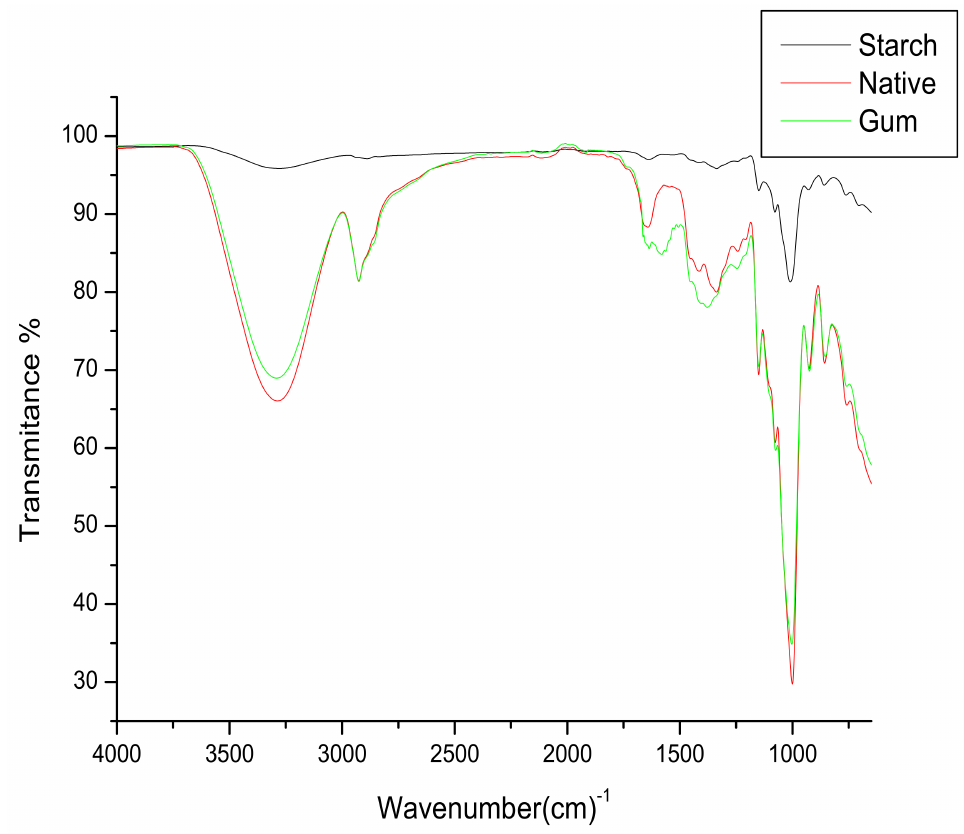
Figure 6. FTIR of proso millet starch, native film, and starch–k-carrageenan film. During the FTIR analysis, different native film peaks were observed. The peak at 479.79 cm − 1 represents polysulfides (S–S stretch) group; 522.54 cm − 1 and 559.28 cm − 1 represent aliphatic iodo compounds (C–I stretch); 758.51 cm − 1 represents aliphatic chloro compounds (C–Cl); 857.38 cm − 1 represents peroxides (C–O–O– stretch); 926.25 cm − 1 represents aliphatic phosphates (P–O–C stretch); 1076.30 cm − 1 and 1149.93 cm − 1 represent aliphatic fluoro compounds (C–F); 1242.90 cm − 1 represents epoxy and oxirane rings; 1337.37 cm − 1 represents primary or secondary (OH in-plane bend group); 1414.34 cm − 1 represents carboxylate (carboxylic acid salt); 1641.39 cm − 1 represents primary amine (NH bend); 1985.25 cm − 1 represents aromatic combination bands; 2113.25 cm − 1 represents different ions such as thiocyanate, cyanide, and related derivatives; 2925.98 cm − 1 represents methoxy, C–H stretch (CH 3 –O–); 3287.98 cm − 1 represents ammonium ions. During the FTIR analysis of the CG film, different peaks were observed. The peak at 479.93 cm − 1 represents the polysulfides (S–S stretch) group; 521.67 cm − 1 and 558.75 cm − 1 represent aliphaticiodo compounds (C–I stretch); 758 cm − 1 represents aliphatic chloro compounds (C–Cl); 854.55 cm − 1 represents peroxides (C–O–O–) stretch; 924.62 cm − 1 represents aliphatic phosphates (P–O–C stretch); 1074.84 cm − 1 and 1149.68 cm − 1 represent aliphatic fluoro compounds (C–F); 1246.13 cm − 1 represents epoxy and oxirane rings; 1378.25 cm − 1 represents primary or secondary (OH in-plane bend); 1505.38 cm − 1 represents (C=C–C) aromatic ring stretch; 1580.24 cm − 1 represents secondary amine (>N–H bend); 1636.53 cm − 1 represents primary amine (NH bend); 1662.91 cm − 1 and 1914.05 cm − 1 show aromatic combination bands; 2113.80 cm − 1 represents cyanide ion, thiocyanate ion, and related ions; 2925.71 cm − 1 represents methoxy, C–H stretch (CH 3 –O–); 3290.07 cm − 1 represents ammonium ions. Guan et al. [48] observed that the inclusion of k-carrageenan results in shifting absorption bands toward 3280 cm − 1 and 2922 cm − 1 , which ultimately showed blending. Ramos et al. [49] demonstrated specific bands at 998 to 1148 cm − 1 , corresponding to C–C and C–O bond vibrations. Gutierrez et al. [50] demonstrated that